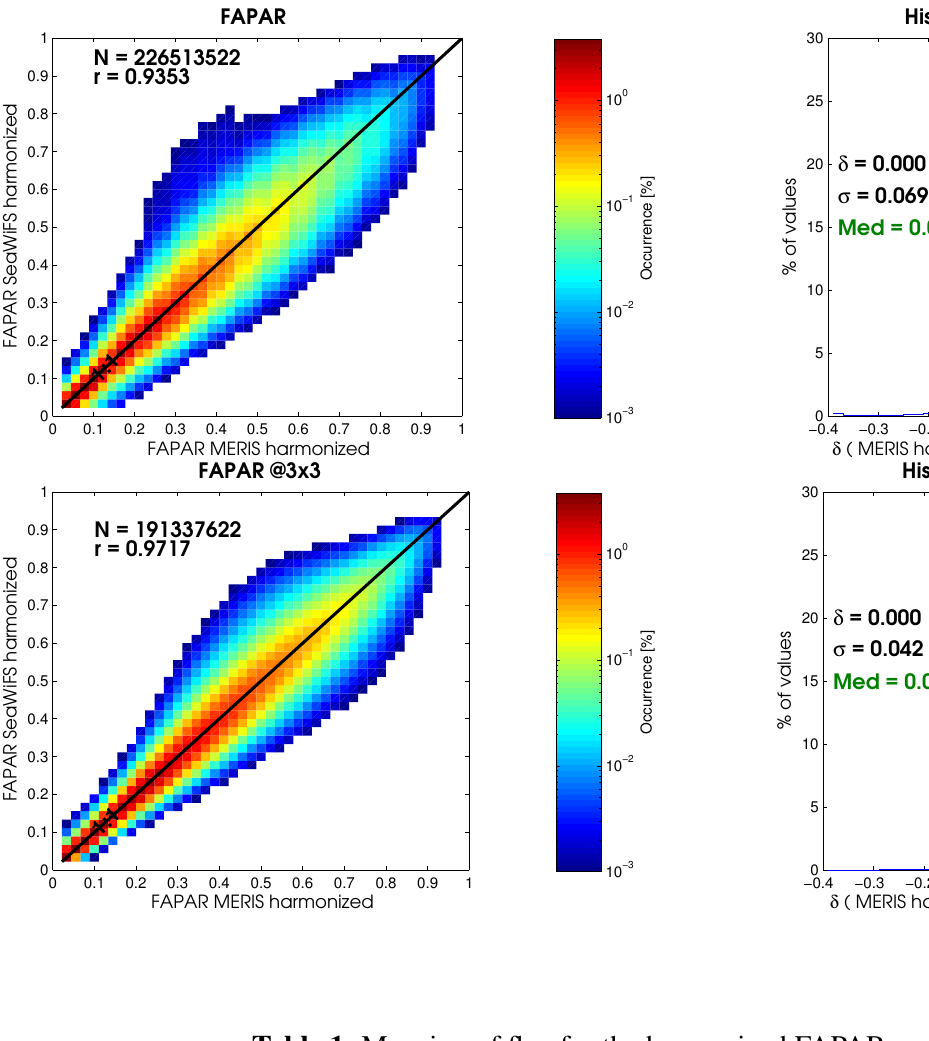
Figure 7. Scatter-plots and histograms of the differences of the FAPAR 10-day product over Europe acquired in 2003 using harmonized products over the 1 × 1 pixel (top panel) and over the 3 × 3 pixel window (bottom panel).